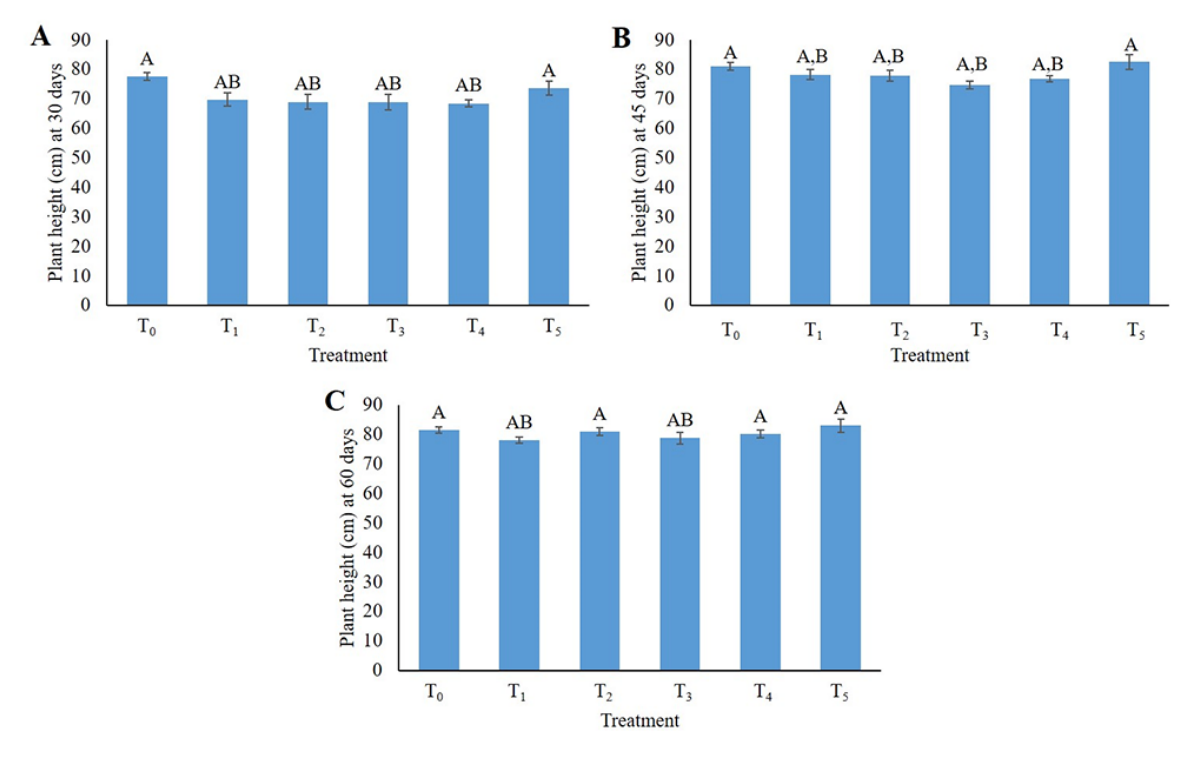
Figure 1 Influences of boron in saline conditions on the plant height of the rice ‘Swarna.’ ( A ) 30 DAT; ( B ) 45 DAT; and ( C ) 60 DAT. T0: Saline condition, EC = 9.0 dS/m + no additional boron; T1: No saline condition + no additional boron; T2: Saline condition of EC 9.0 dS/m + boron application as solubor at a rate of 4.5 kg B ha − 1 ; T3: Saline condition of EC 9.0 dS/m + boron application as solubor at a rate of 5.9 kg B ha − 1 ; T4: Saline condition of EC 9.0 dS/m + boron application as solubor at a rate of 7.5 kg B ha − 1 ; T5: Saline condition of EC 9.0 dS/m + boron application as solubor at a rate of 10 kg B ha − 1 . Data are the means of four replicates ± SEM . All data were analyzed by one-way analysis of variance. Tukey’s test was used to identify the differences between treatments. Values with different superscript characters (A, B, C) are significantly different ( p <